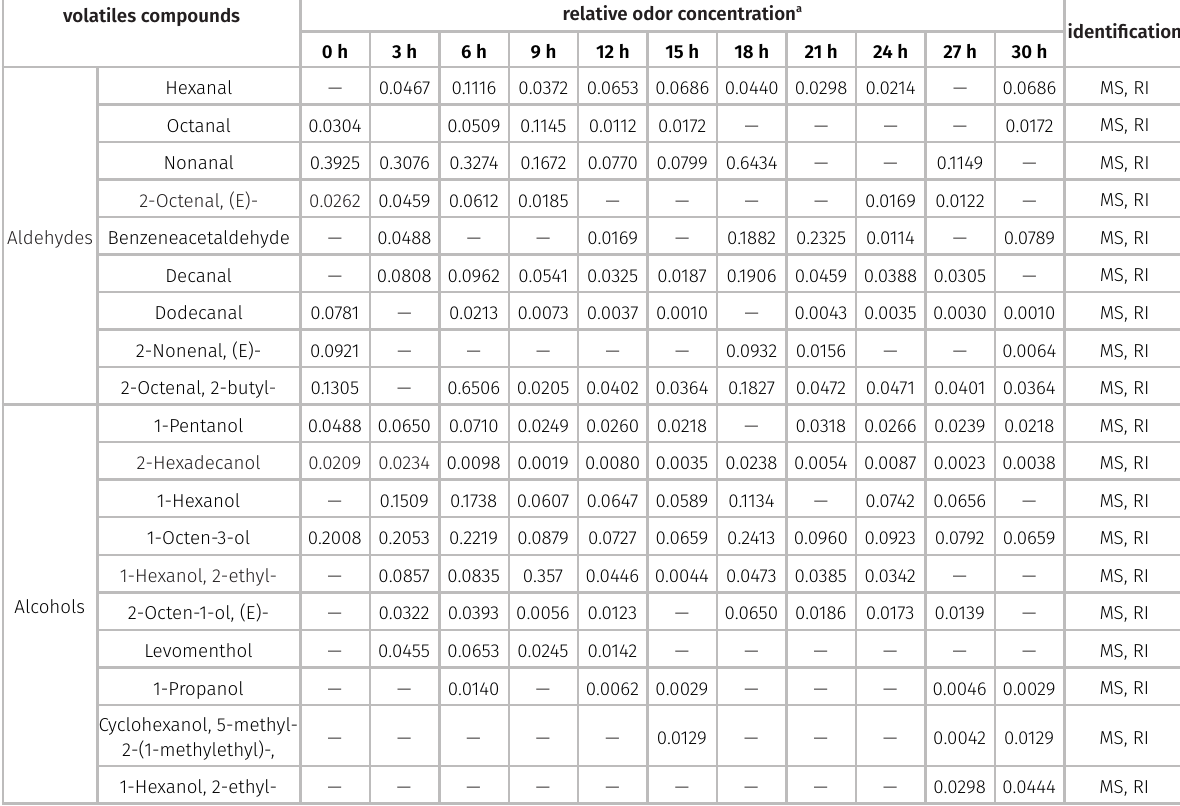
Table II. Relative contents of volatile compounds in potato/wheat fresh wet noodles at different storage times (the concentration: ng/g). volatiles